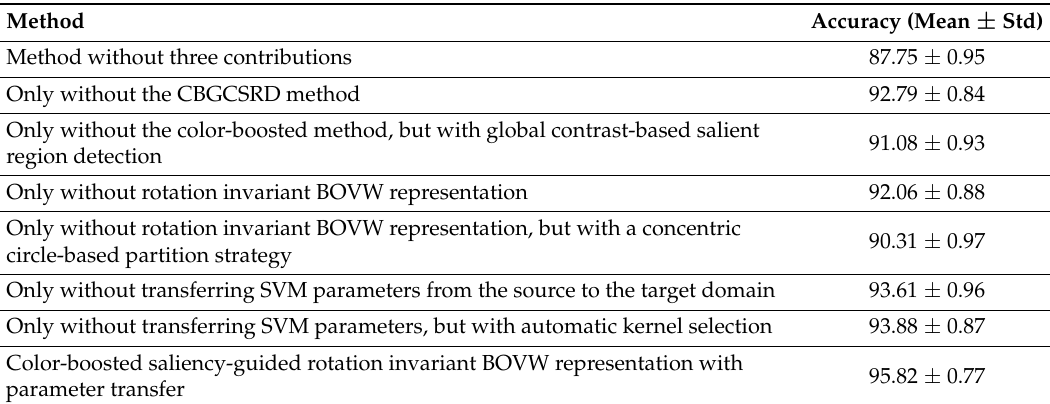
Table 3. Comparison with methods without three contributions in the WHU-RS dataset.